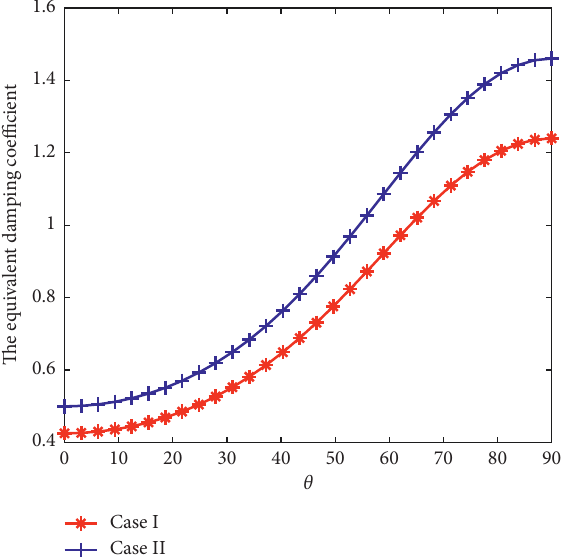
Figure 37: The equivalent damping coefficients versus structural damping for cases I and II.